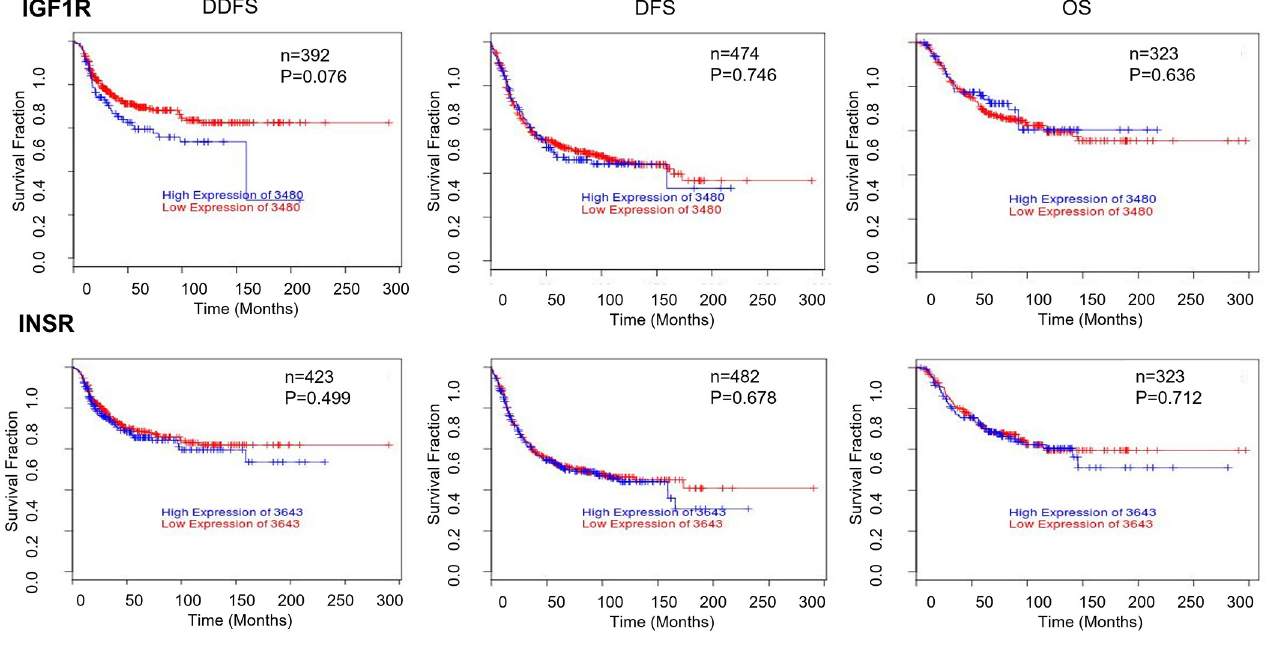
Fig 2. Kaplan Meier curves for distant disease free survival (DDFS), disease-free survival (DFS) and overall survival (OS) based on expression levels of IGF1R and IR mRNA in basal-like breast cancer, using the ssp2006 classifier on BreastMark.